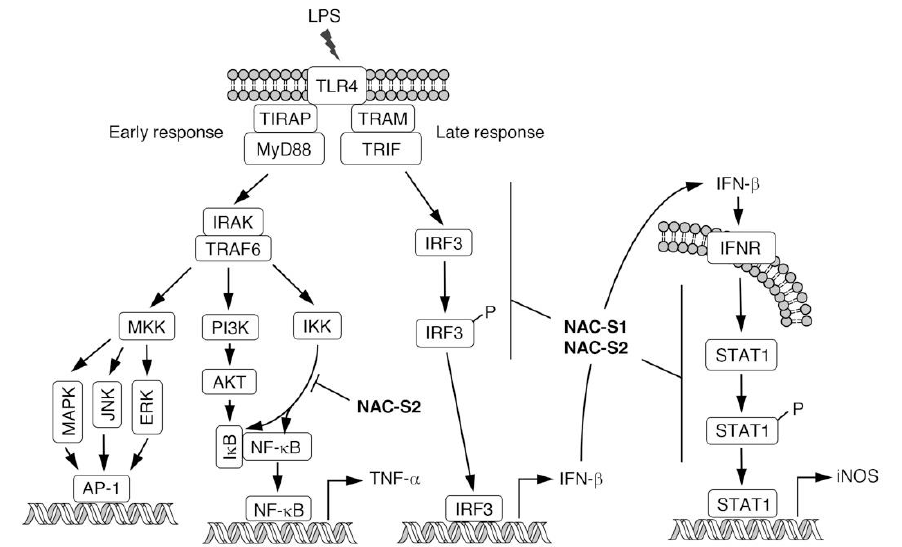
Figure 6. Schematic representation of LPS-TLR4-mediated inflammatory responses. NAC polysulfides can inhibit signal transduction at the points indicated. LPS, lipopolysaccharide; TLR4, toll-like receptor 4; MKK, MAP kinase kinase; MAPK, mitogen-activated protein kinase; JNK, c-Jun NH 2 -terminal kinase; ERK, extracellular signal-regulated kinase; PI3K, phosphatidylinositol-3 kinase; IKK, I κ B kinase; AKT, protein kinase B; IRF3, interferon regulatory factor 3; INFR, interferon receptor; STAT1, signal transducers and activators of transcription 1; iNOS, inducible nitric oxide synthase.